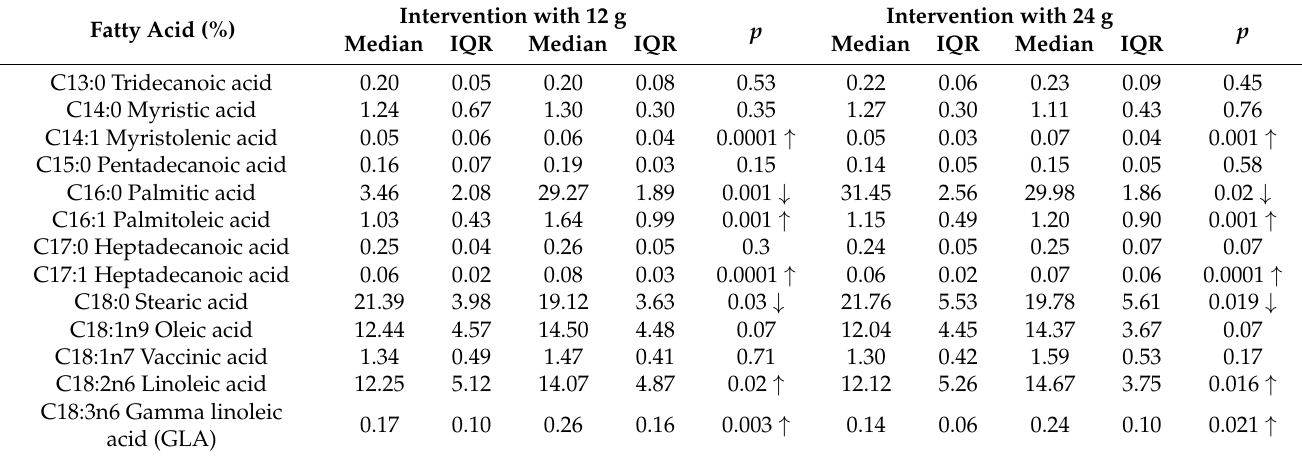
Table 2. Fatty acids profile before and after 8 weeks of high-fiber buns